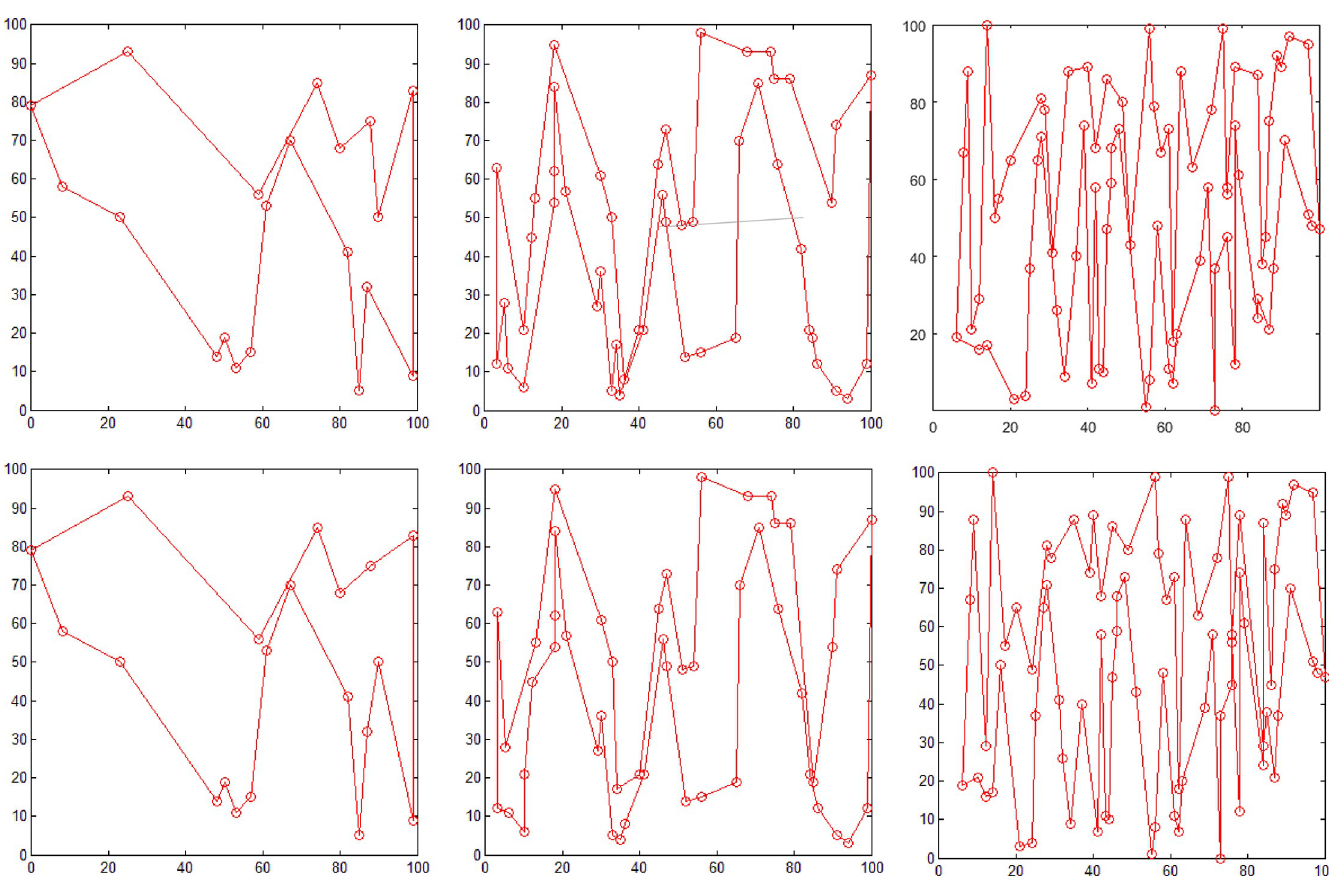
Fig 12. Experimental results of polygon generation. Polygons consisting of (a1)-(a2) 20, (b1)-(b2) 50, and (c1)-(c2) 80 points.